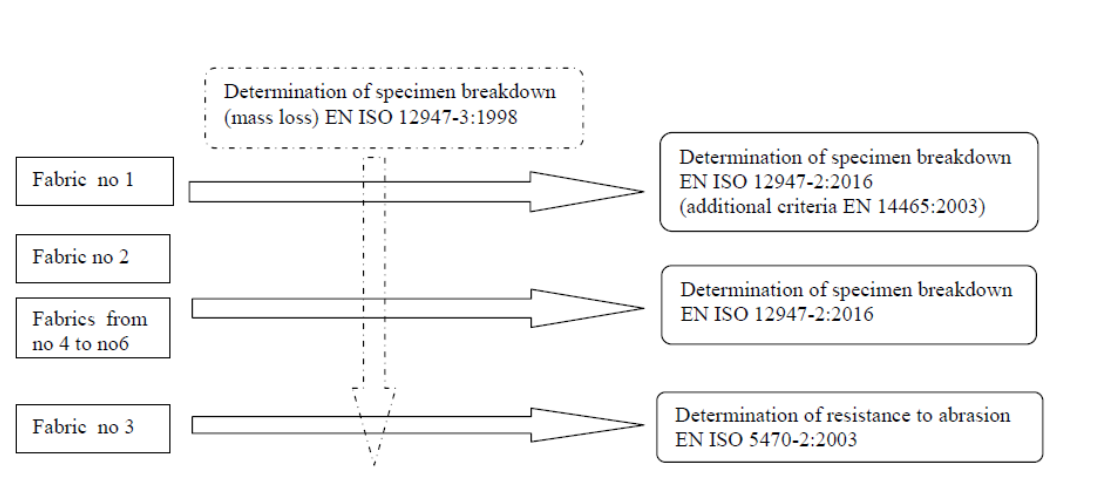
Figure 2. The characteristic of